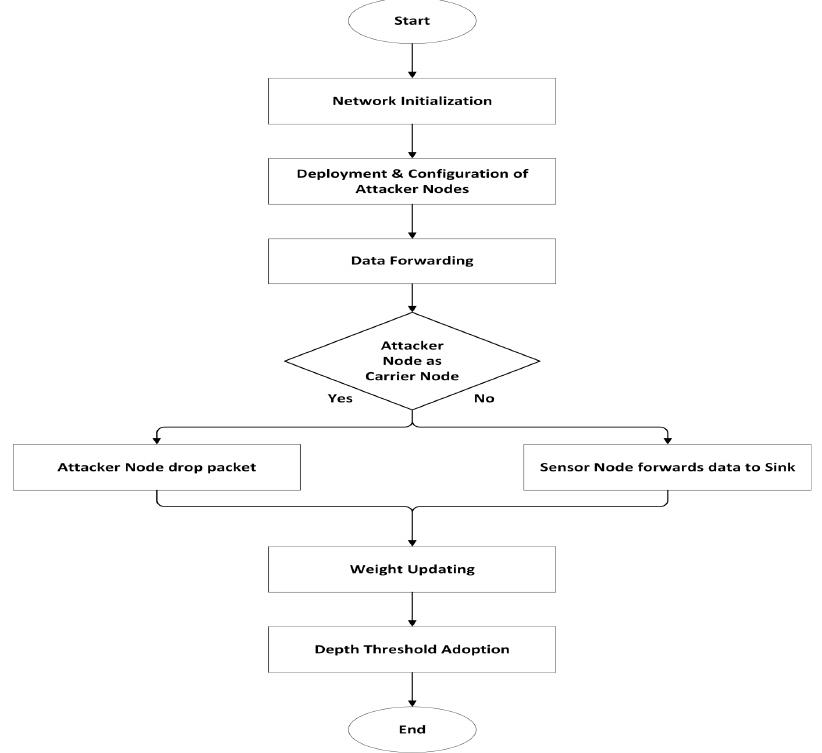
Figure 3. Active Attack in AMCTD.